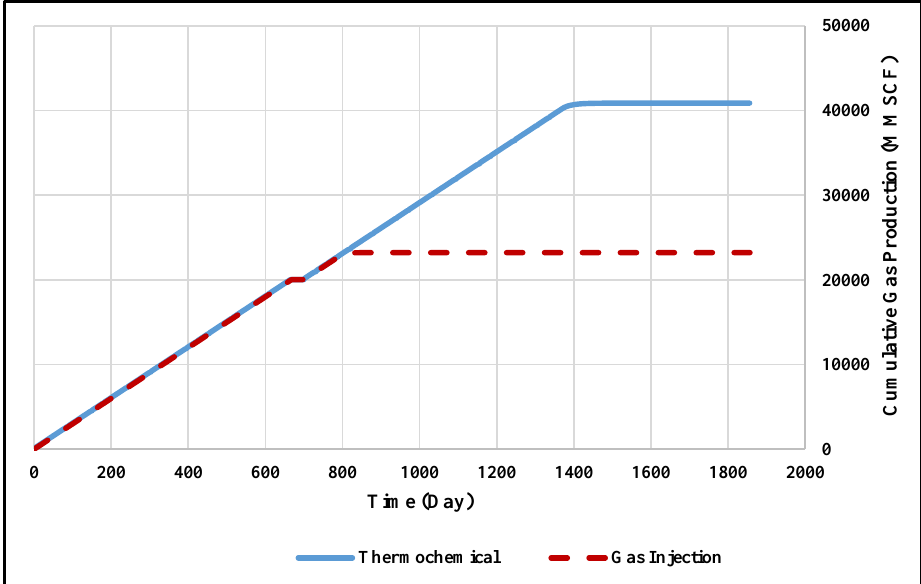
Figure 21. Profiles of cumulative gas production during thermochemical treatment and gas injection.